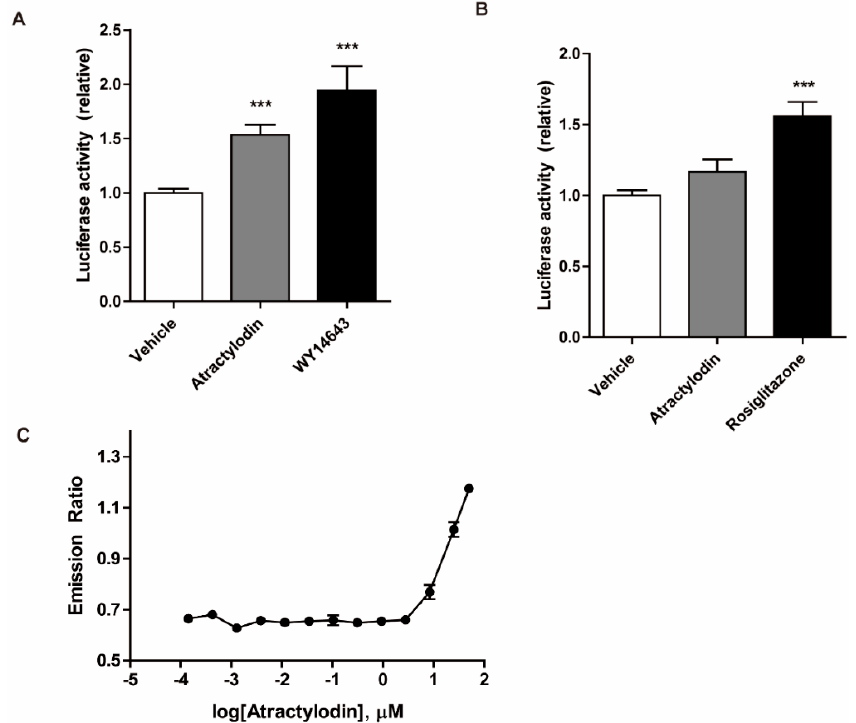
Figure 4. Transcriptional activity of PPAR α and PPAR γ , and the in vitro ligand-binding activity of PPAR α . ( A , B ) HCT116 cells were transfected with PPRE and ( A ) PPAR α or ( B ) PPAR γ . Transfected cells were treated with vehicle (0.1% DMSO), atractylodin (50 µ M), WY14643 (10 µ M), or rosiglitazone (10 µ M) for 5 h. The luciferase activity was detected using a luminometer. Data are presented as a percentage of the vehicle-treated group. *** p < 0.001 compared to the vehicle-treated group. ( C ) The binding of atractylodin and PPAR α was tested by the time-resolved FRET coactivator assay. Serial dilution of atractylodin (between 0.1 nM and 50 µ M), 5 nM PPAR α -ligand binding domain, 250 nM fluorescein PGC1a, and 5 nM Tb anti-glutathione-S-transferase antibody were included in the assay composition and incubated for 1 h. The emission ratio (520:495) was calculated and the curves were generated using a sigmoidal dose response equation.